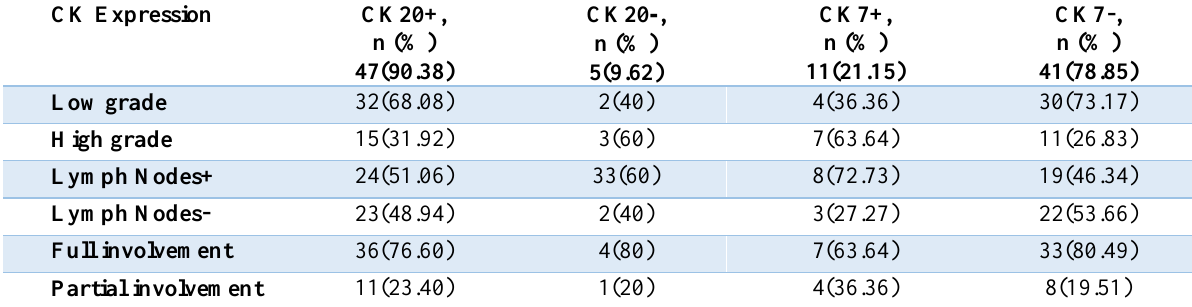
Table 1. CK7/CK20 Expression and Clinicopathological Findings in Colon Adenocarcinoma